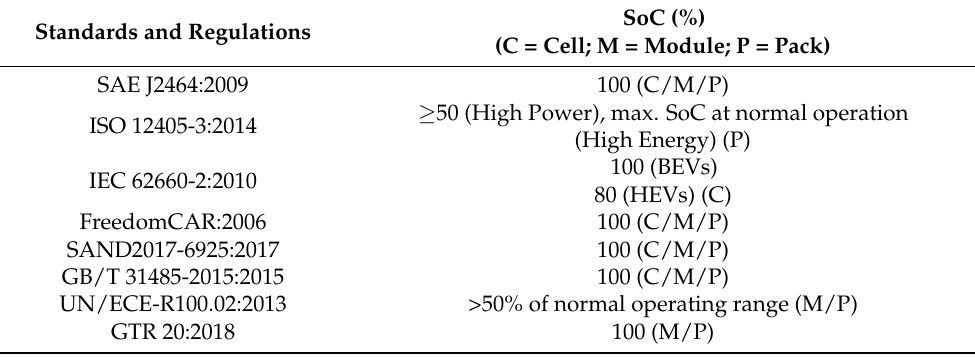
Table 5. SoC level as per different standards and regulations.